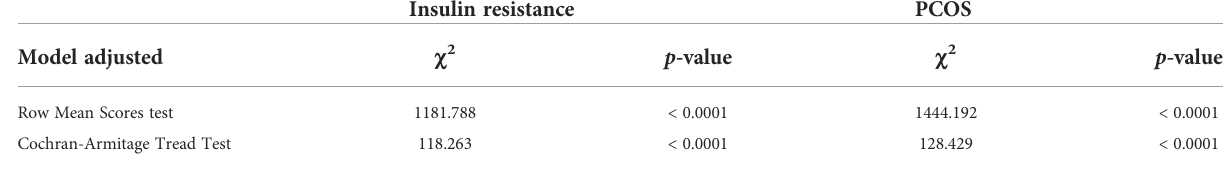
TABLE 4 Row Mean Scores and Cochran-Armitage Trend test of the impact of circulating GPHB5 levels on IR and